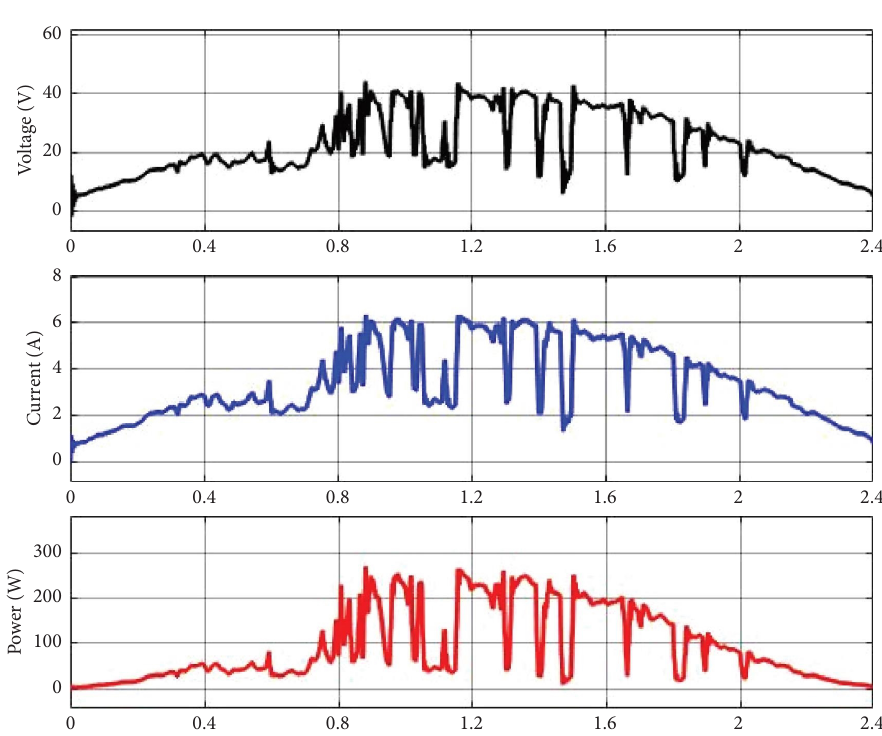
Figure 24: Input voltage, current, and power at